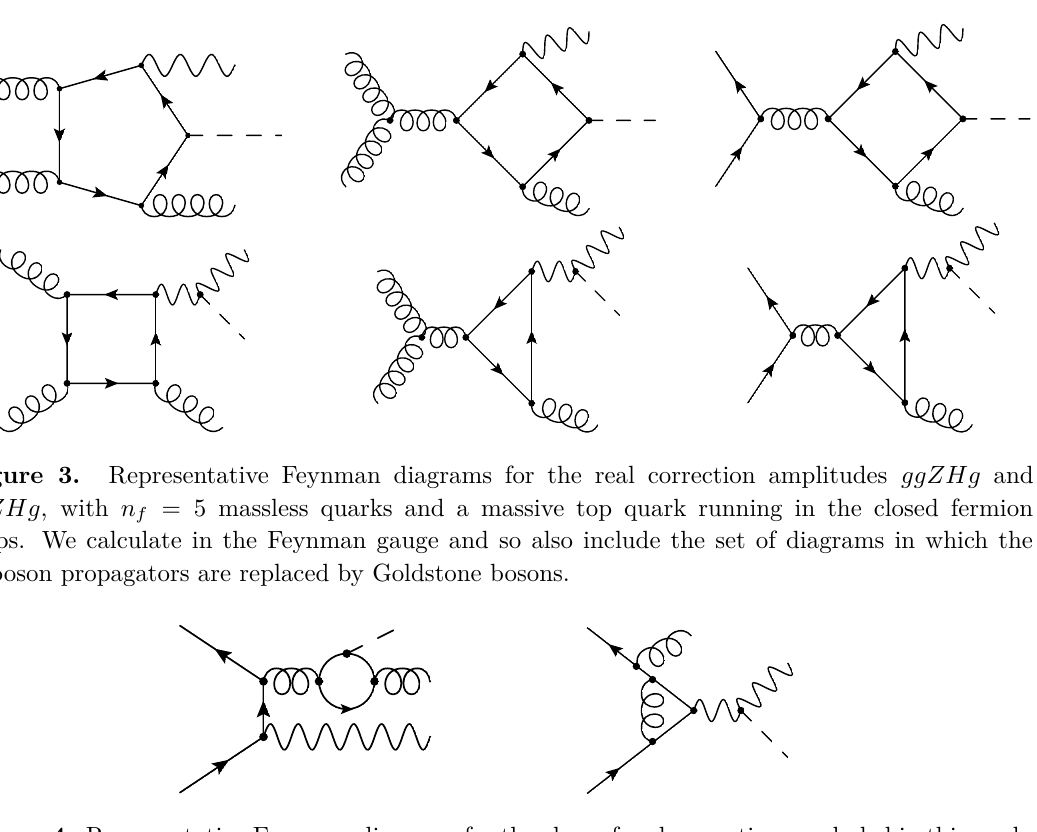
Figure 4. Representative Feynman diagrams for the class of real corrections excluded in this work; we exclude diagrams in which the Z boson couples to the external quark